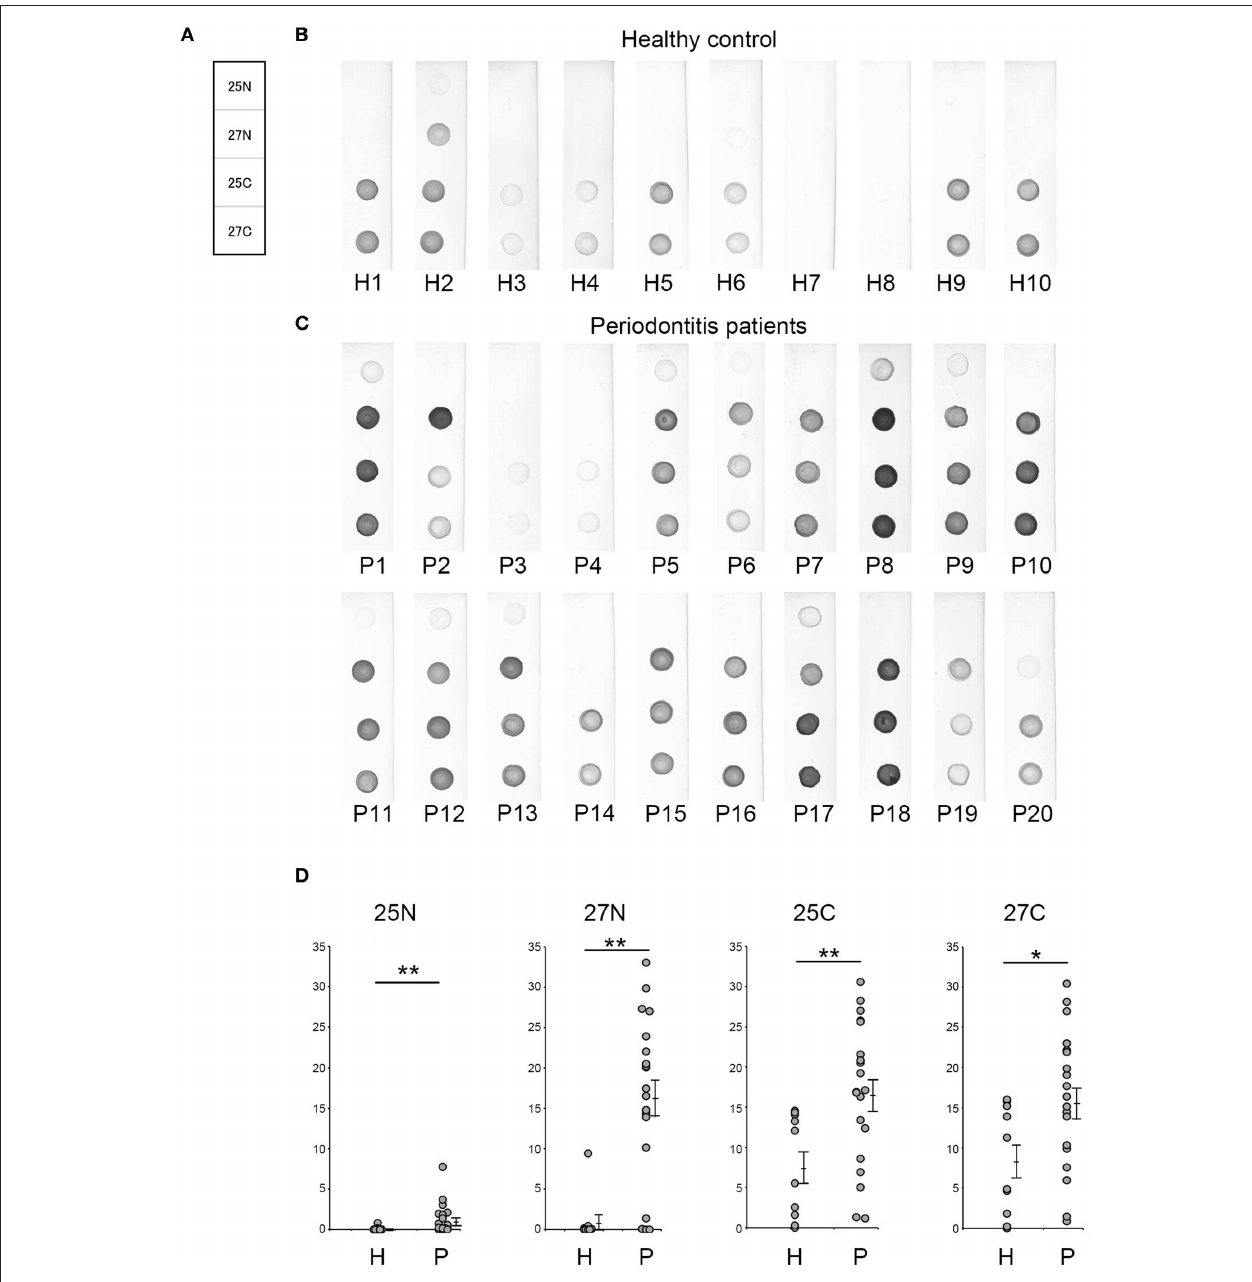
FIGURE 6 | Serum IgG responses to the recombinant antigens as determined by dot blot analysis. (A) The panel shows a scheme of the proteins spotted. Representative results of the sera used from healthy individuals ( B : H1–H10) and patients with periodontitis ( C : P1–P20) are shown. Approximately 50 ng of each protein was spotted on the membrane, and sera were used at a dilution of 1:2,500. (D) Spot intensities were normalized relative to the background signals and represented as relative intensities. Mean values and standard errors are shown on the right. ** P < 0.01, * P < 0.05, N, N-terminal half; C, C-terminal half; H, Healthy control; P, Patients with